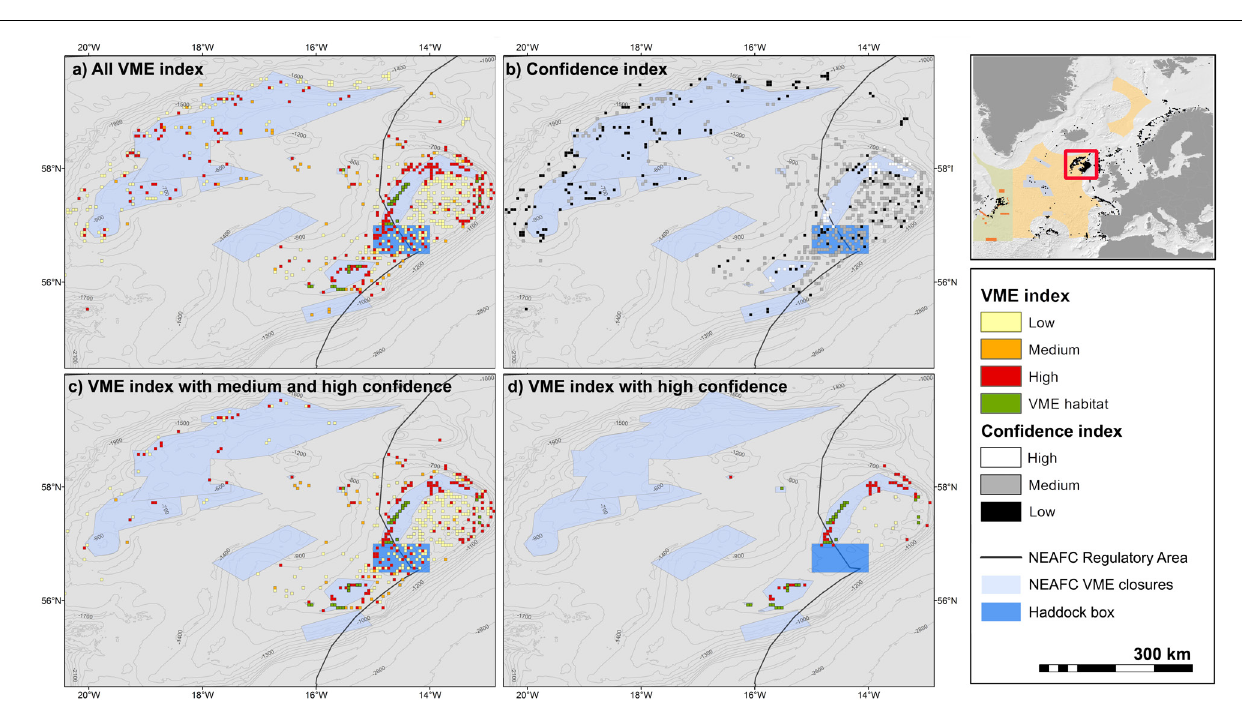
FIGURE 5 | Applying the VME index and confidence index to the VME database: Rockall and Hatton Bank. (a) VME index for all cells with data in the ICES VME database; (b) confidence index for all cells with data in the ICES VME database; (c) VME index for cells with medium and high confidence; and (d) VME index for cells with high